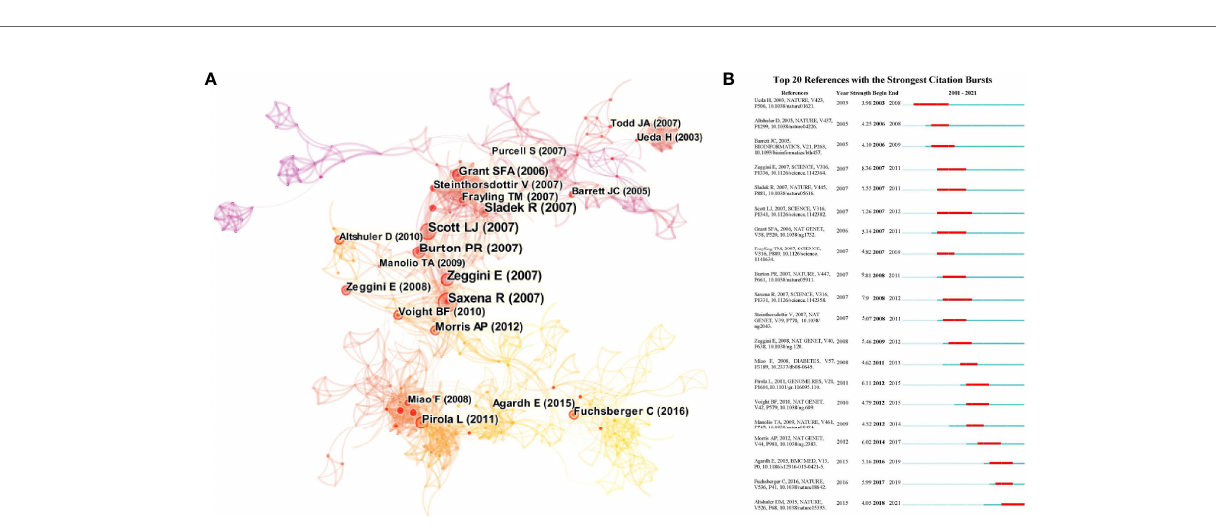
FIGURE 3 | (A) The document co-citation network clustering. The nodes and links are distinguished by colors, in which cool-toned color refers to an earlier co-citation relationship. References with > 10 citations are displayed in the landscape in nodes named by fi rst author (publication year). The size of the node represents the citation number. Nodes with red ring serve as the references with citation bursts meaning emergence of new trends. The links refer to the beginning of the connections. (B) The top 20 references with the strongest bursts. The red bar refers to the burst duration. The appearance of dark blue bar represents the publication of the article. The burst strength indicates the importance of this article to the research fi eld.